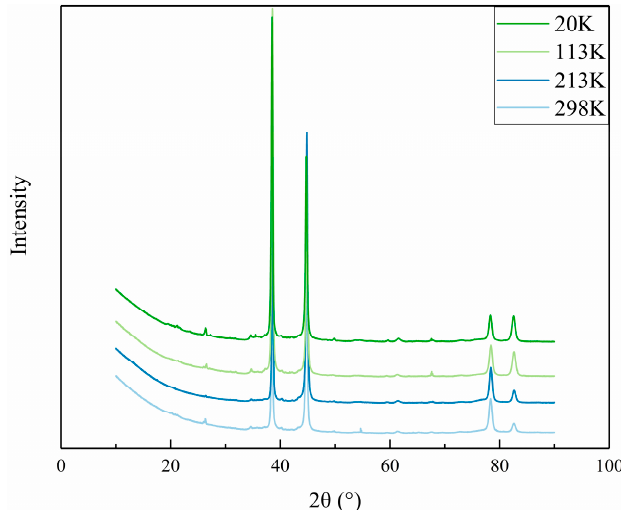
Figure 9. XRD patterns of the sample after fracture at different aging Figure 9. XRD pa tt erns of the sample after fracture at di ff erent aging temperatures.